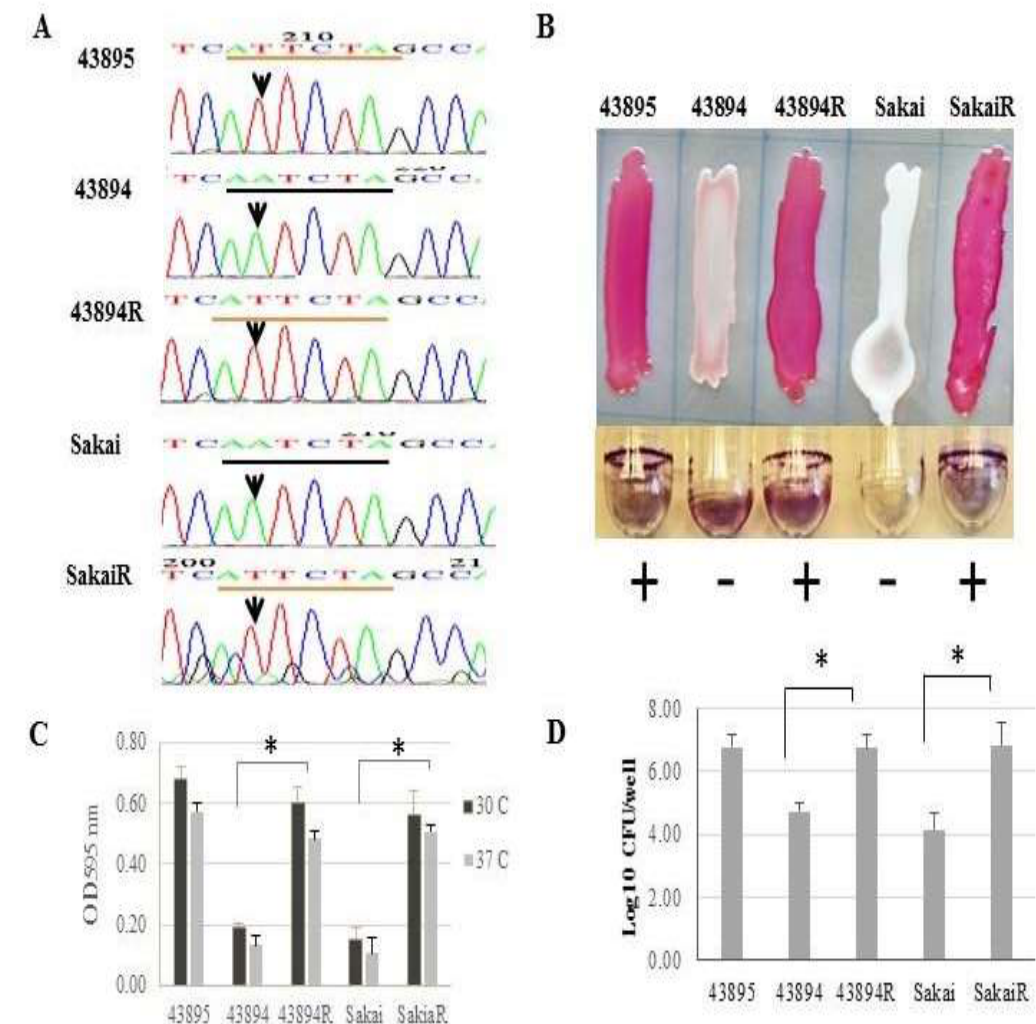
Figure 3. A single nucleotide change in the O157 csgD promoter confers Congo red binding, biofilm production, and invasion phenotypes . Site-directed mutagenesis was used to generate an A to T transversion in the curli regulatory region of 43894 and Sakai, designated 43894R and SakaiR, respectively. ( A ) The DNA sequence of parental and mutagenized strains are compared to 43895. The arrow denotes the T or A of each strain. ( B ) Congo red dye-binding and biofilm formation were compared by growing each strain on Congo red indicator agar or in LB broth without aeration at 37 ◦ C, respectively. The single base pair changes in 43894R and SakaiR conferred dye-binding and biofilm formation ( + or -) equivalent to 43895. ( C ) Biofilm formation was quantified by a microtiter assay. Strains were incubated at 30 ◦ C or 37 ◦ C in minimal salts media with 4% glucose. Bound crystal violet was solubilized with 95% ethanol and measured by absorbance at 595 nm. Assays were performed six times / strain. Bars represent + SE and * denotes p < 0.05. At both temperatures, the single base change in 43894R and SakaiR conferred biofilm formation equivalent to 43895. ( D ) Epithelial cell invasion was measured by a gentamicin protection assay. Bacteria were co-cultured with MAC-T monolayers (MOI = 10) and CFUs determined by plate count (triplicate experiments, three replicates / strain). The single base change in 43894R and SakaiR conferred epithelial cell invasion similar to 43895. Bars represent + SE and * denotes p < 0.05.